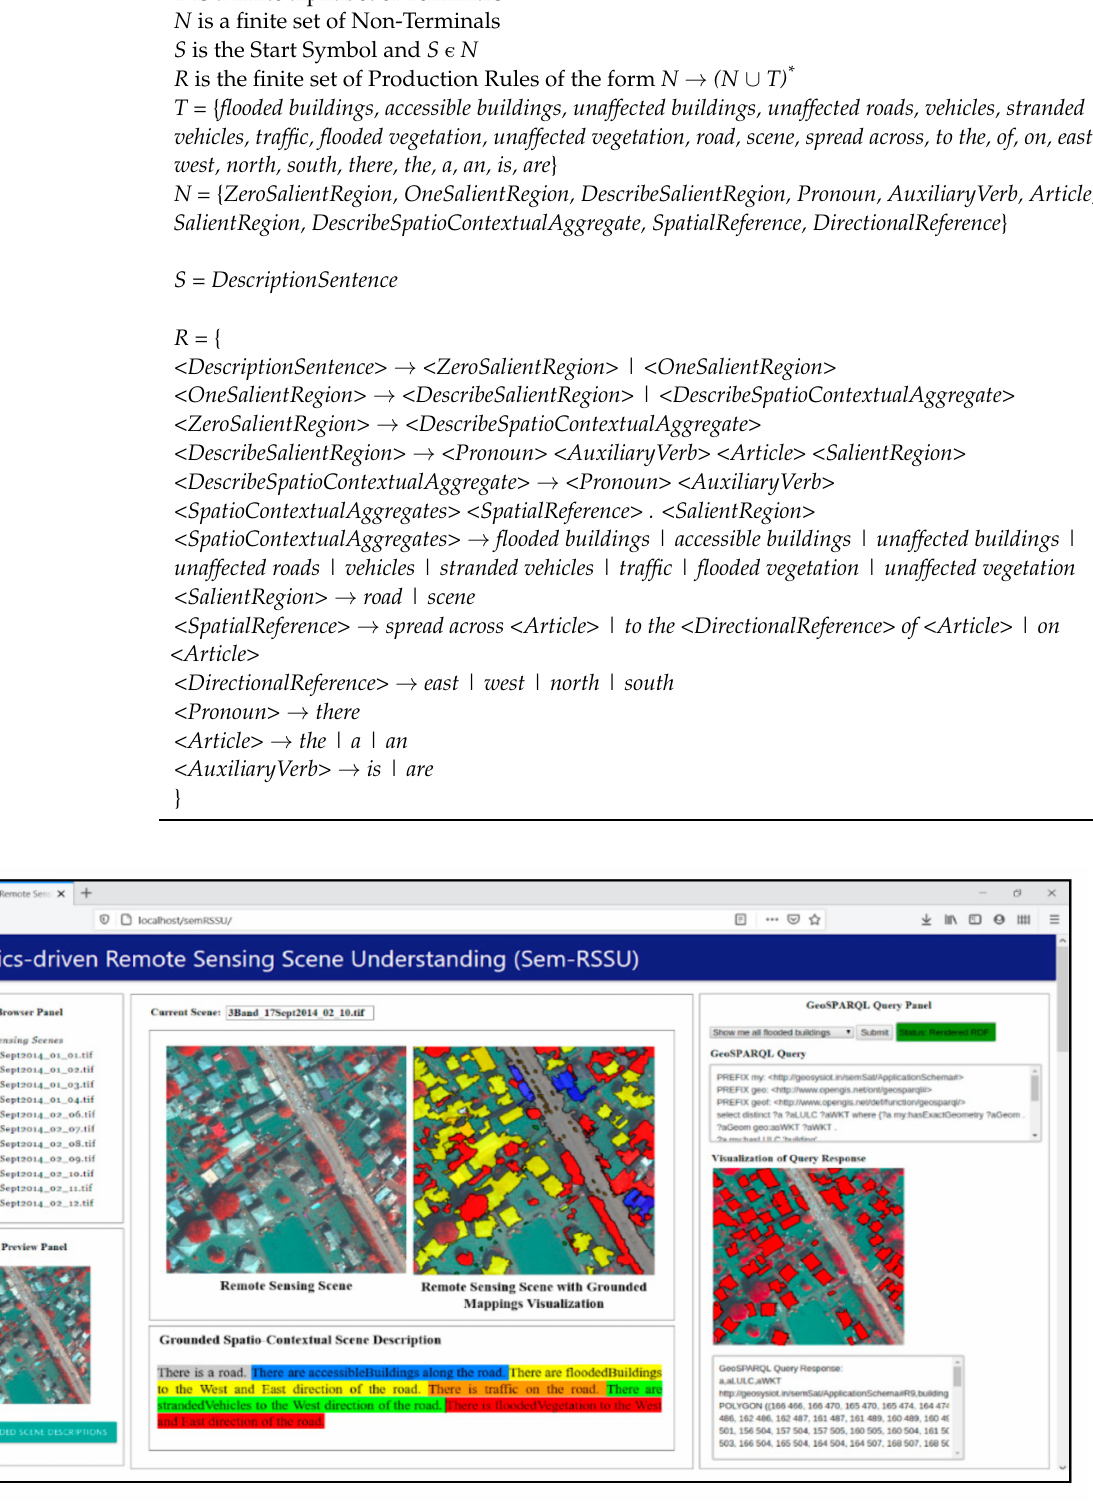
Figure 14. Web-based application front-end implementing the Sem-RSSU